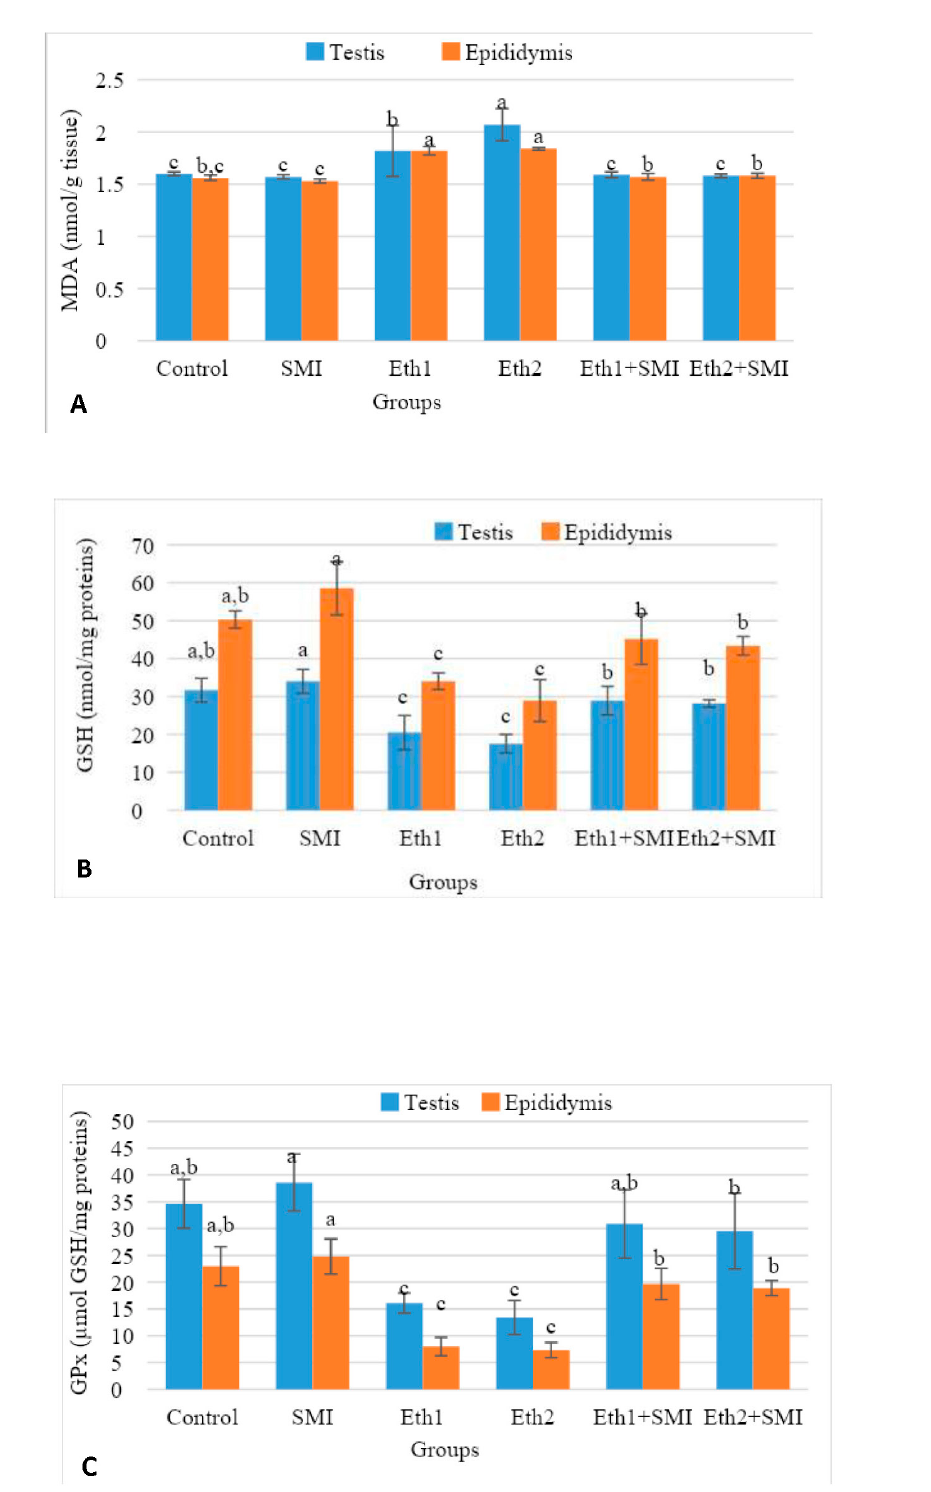
FIGURE 1 - Variation of oxidative stress parameters (mean ± SD) in testis and epididymis of Wistar rat of control group and treated groups after six consecutive weeks of treatment. A: Variation of tissue MDA concentration in testis and epididymis; B: variation of glutathione reductase levels in testis and epididymis; C: variation of glutathione peroxidase level in testis and epididymis. Means do not share the same letter are significantly different (p< 0.05), according to one-way ANOVA followed by Tukey test. SMI: Silybum marianum seeds-infused solution; Eth1:01 g/kg/day; Eth2: 02